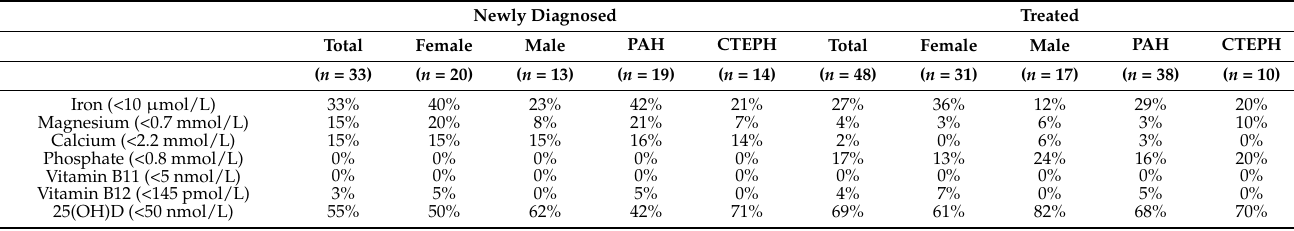
Table 3. Percentage of patients below the reference value for micronutrients in newly diagnosed and treated patients, split by gender and disease classification.